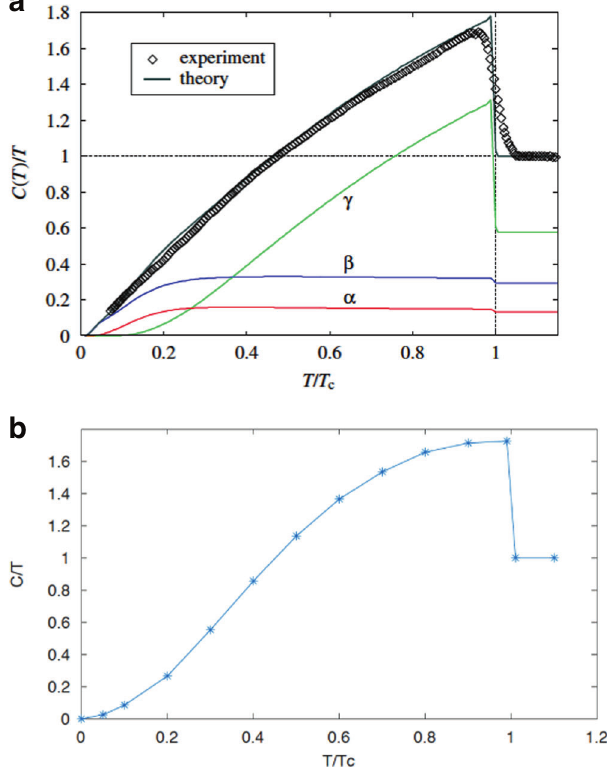
Fig. 2 a Measured speci fi c heat coef fi cient of Sr 2 RuO 4 from ref. 47 compared with a model calculation from refs 10, 101 illustrating the decomposition into contributions from the gamma and (alpha + beta) sheets. Good agreement between experiment and theory (at least for temperatures above 100 mK) is not dependent on details since it only requires that the gaps on the two electronic subsystems be fairly similar in magnitude, and it does not matter whether the (alpha + beta) sheet gap or the gamma sheet gap is the larger one. 48 For completeness, the speci fi c heat prediction for the odd parity gap structure of Fig. 1b is shown in b . ( a reproduced from ref.